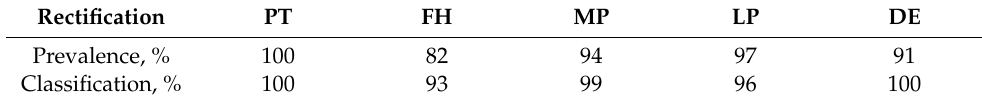
Figure 8. Histograms of local rectification sizes across the training population for ( a ) patella tendon, ( b ) fibula head, ( c ) medial and ( d ) lateral paratibial, and ( e ) distal end design features as mapped on the ( f ) 3D socket shape. − ve denotes buildup; +ve denotes carve. Table 2. Prevalence of each rectification, and accuracy of classification by k-means